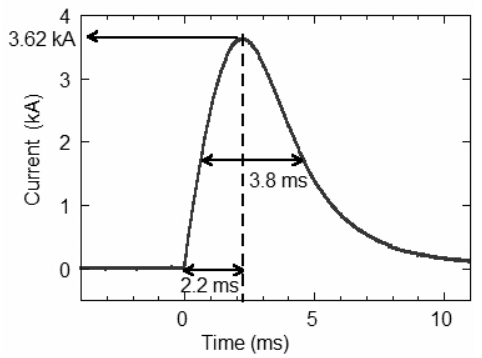
Figure 2. Pulsed current passing through the coil.